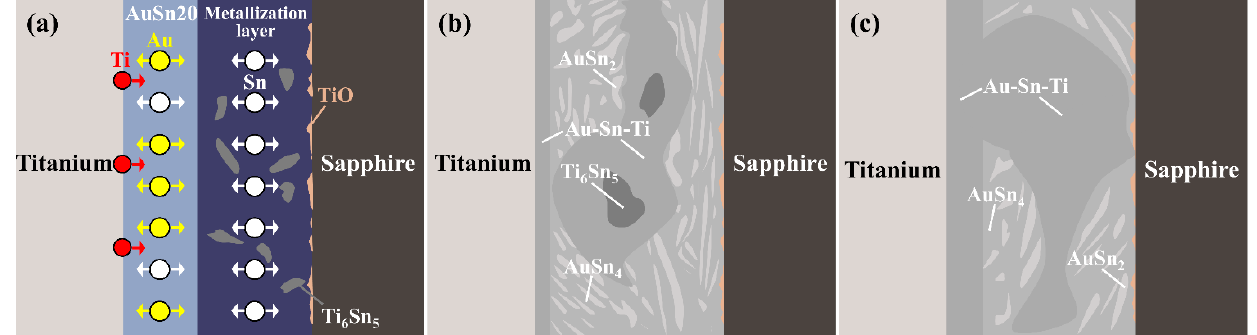
Figure 6. Interfacial microstructure of the titanium/AuSn20/Sn-3Ti/sapphire joints brazed at 550 °C for ( a ) 20 min, ( b ) 25 min, and ( c ) 35 min.